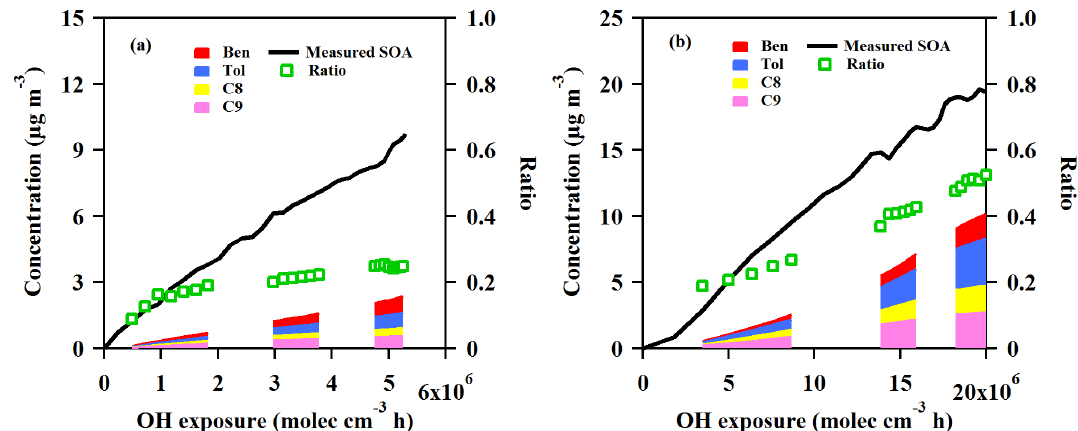
Figure 7. Measured and predicted SOA concentration as a function of OH exposure from GDI vehicle exhaust (a) and PFI vehicle exhaust (b) in the chamber experiments. The black line is the measured SOA concentration with wall loss and particle dilution correction during the experiment. The red, blue, yellow and pink areas are predicted SOA concentration estimated from benzene, toluene, C8 alkylbenzene and C9 alkylbenzene, respectively. The green markers are the ratios of the predicted SOA to the measured